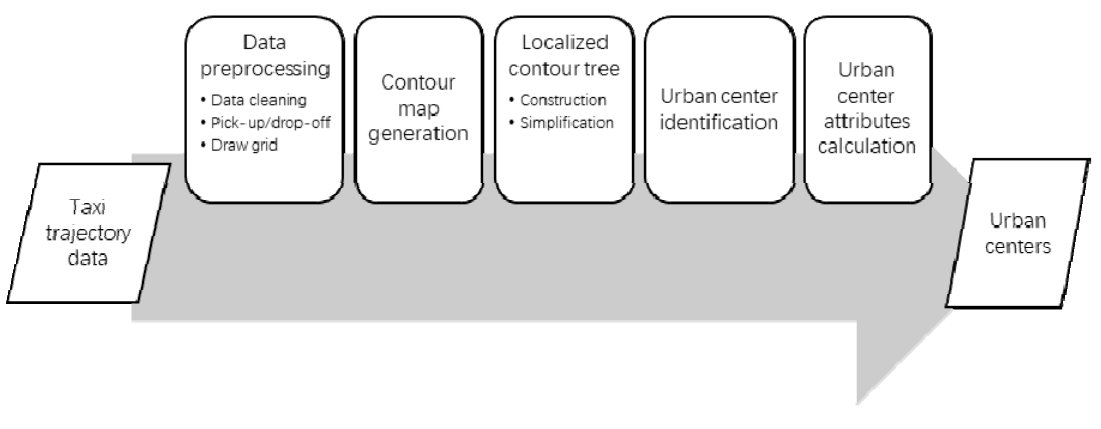
Figure 1. Analysis framework.